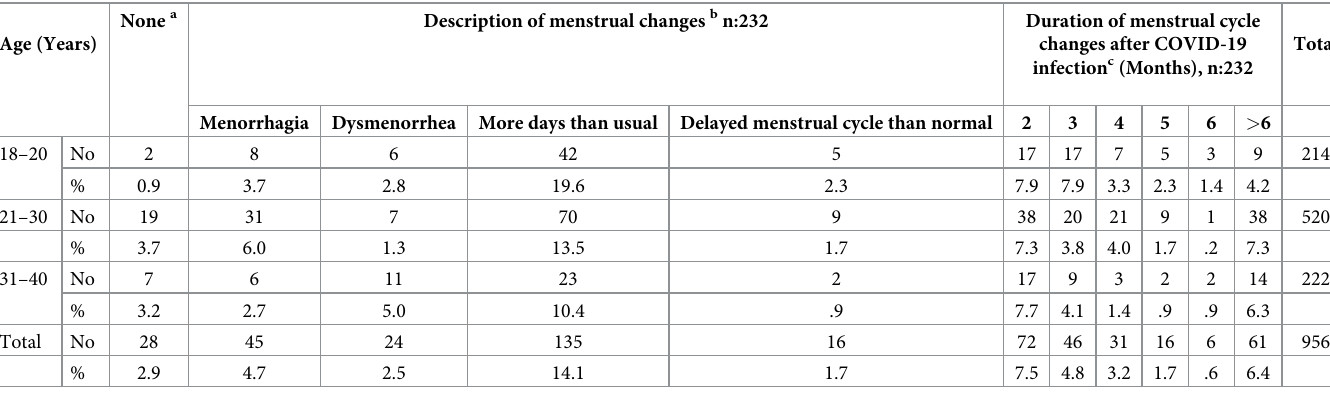
Table 1. Effect of age on the development of menstrual cycle changes following SARS-CoV-2 infection. None a Description of menstrual changes b n:232 Duration of menstrual cycle Age (Years)